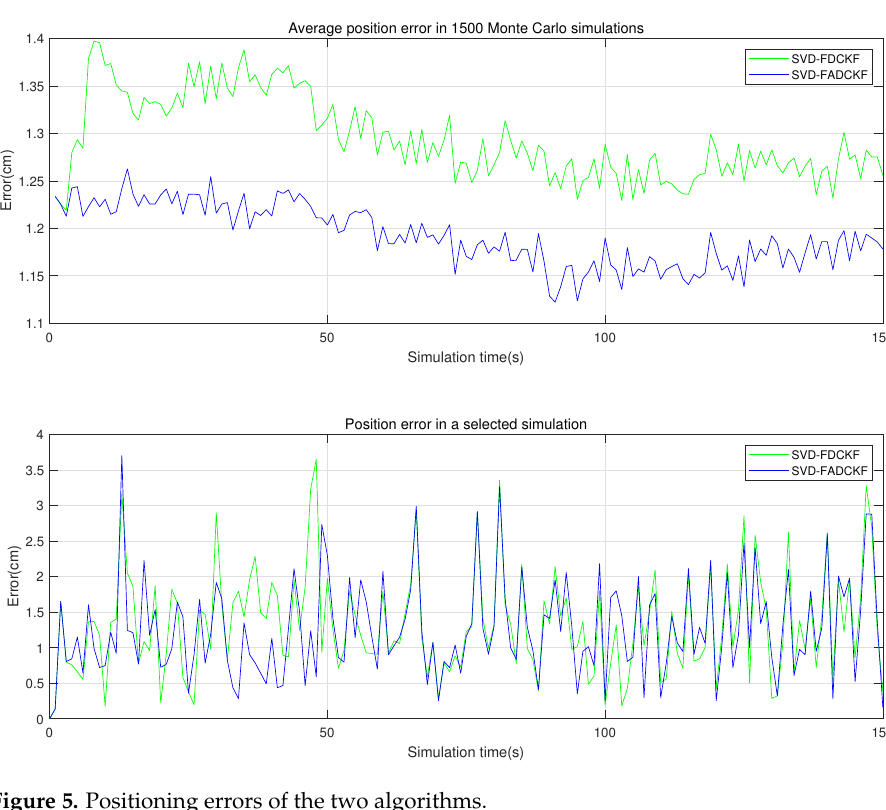
Figure 5. Positioning errors of the two algorithms.